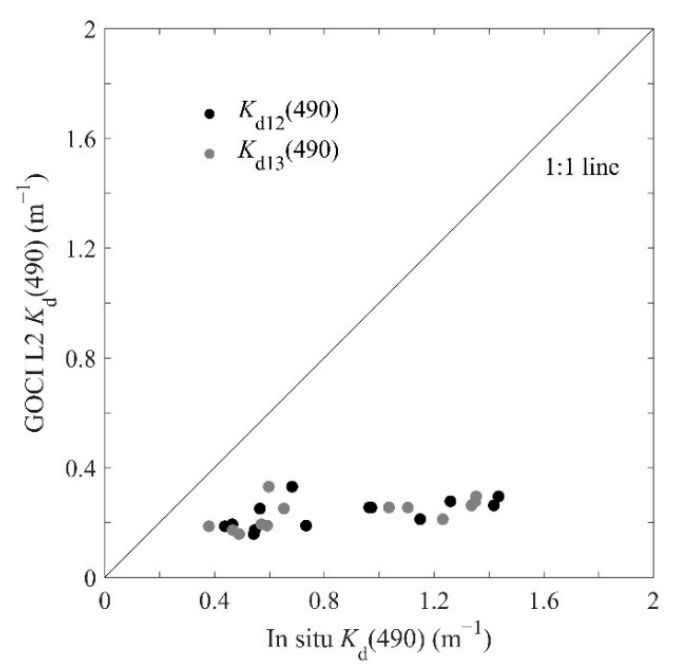
Figure 6. Comparisons between GOCI L2 K d ( 490 ) and buoy-measured K d12 ( 490 ) , as well as K d13 ( 490 ) .